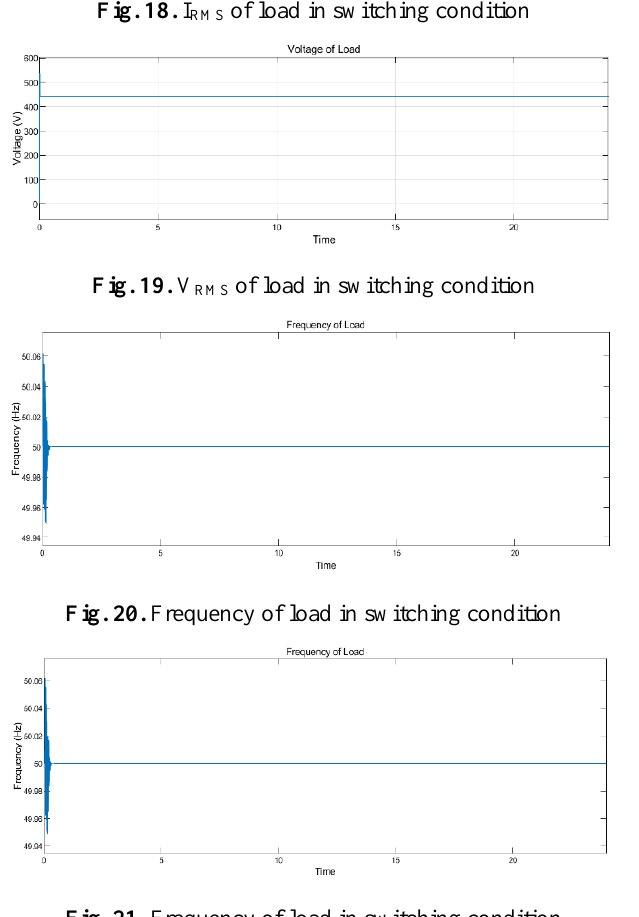
Fig. 21. Frequency of load in switching condition